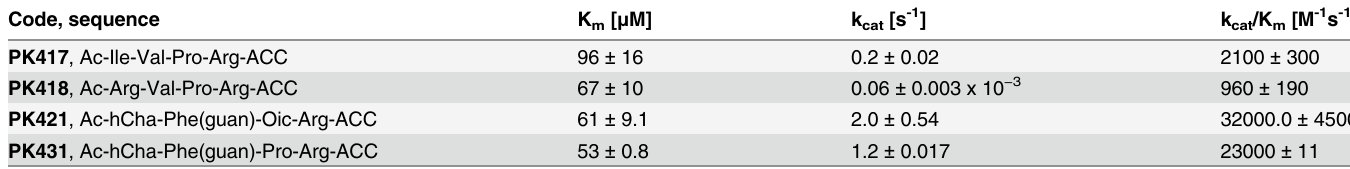
Table 1. Kinetic analysis of tetrapeptide substrates for NSP4. Results are shown as an average of a minimum of 2 separate experiments with S.D. Code,